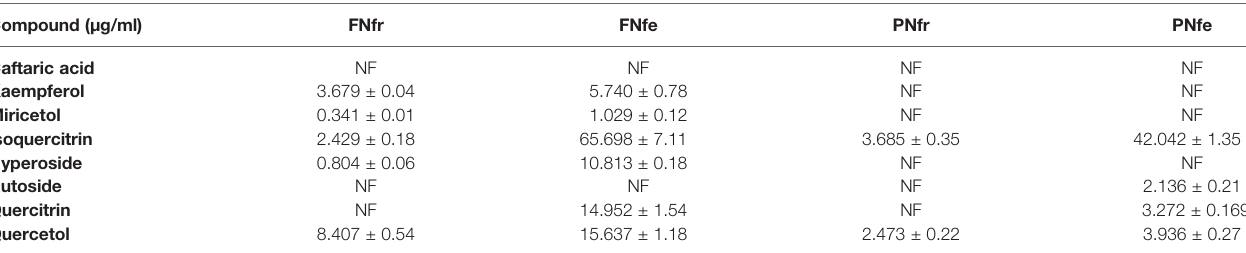
FNfe,Feteasca ̆ neagra ̆ fermentedgrapepomaceextract;FNfr,Feteasca ̆ neagra ̆ freshgrapepomaceextract;PNfe,Pinotnoirfermentedgrapepomaceextract;PNfr,Pinotnoirfreshgrape pomace extract; NF, not found, below the Limit of Detection. Values are expressed as mean ± SD (n =